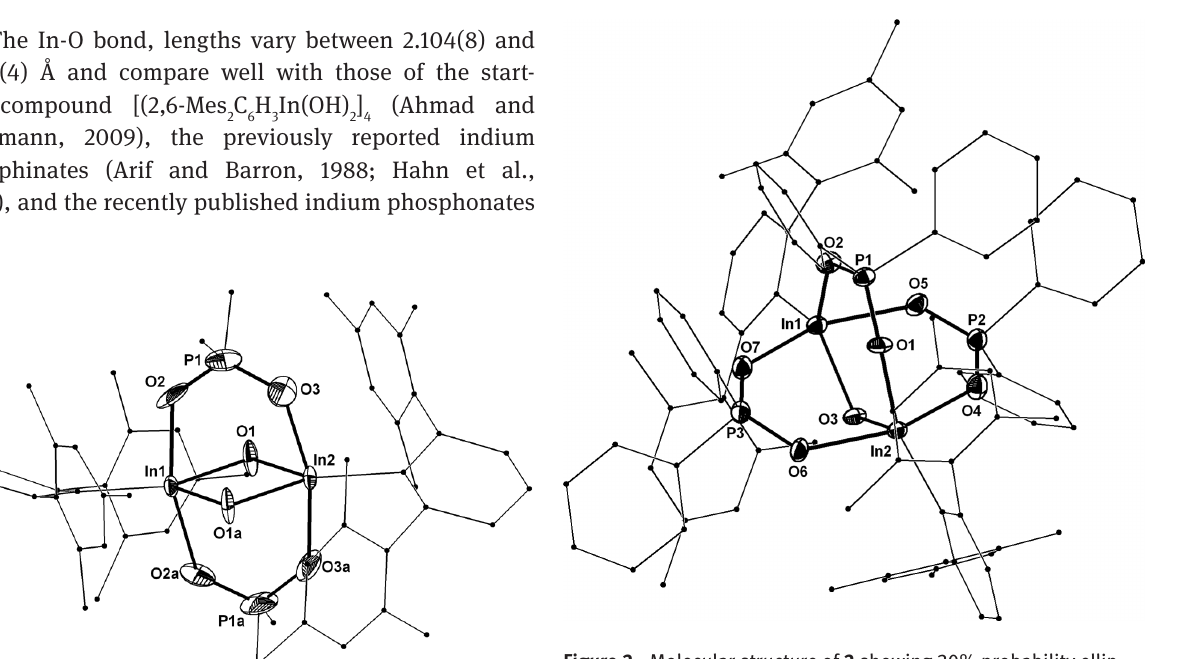
Figure 2 Molecular structure of 2 showing 30% probability ellip- soids and the crystallographic numbering